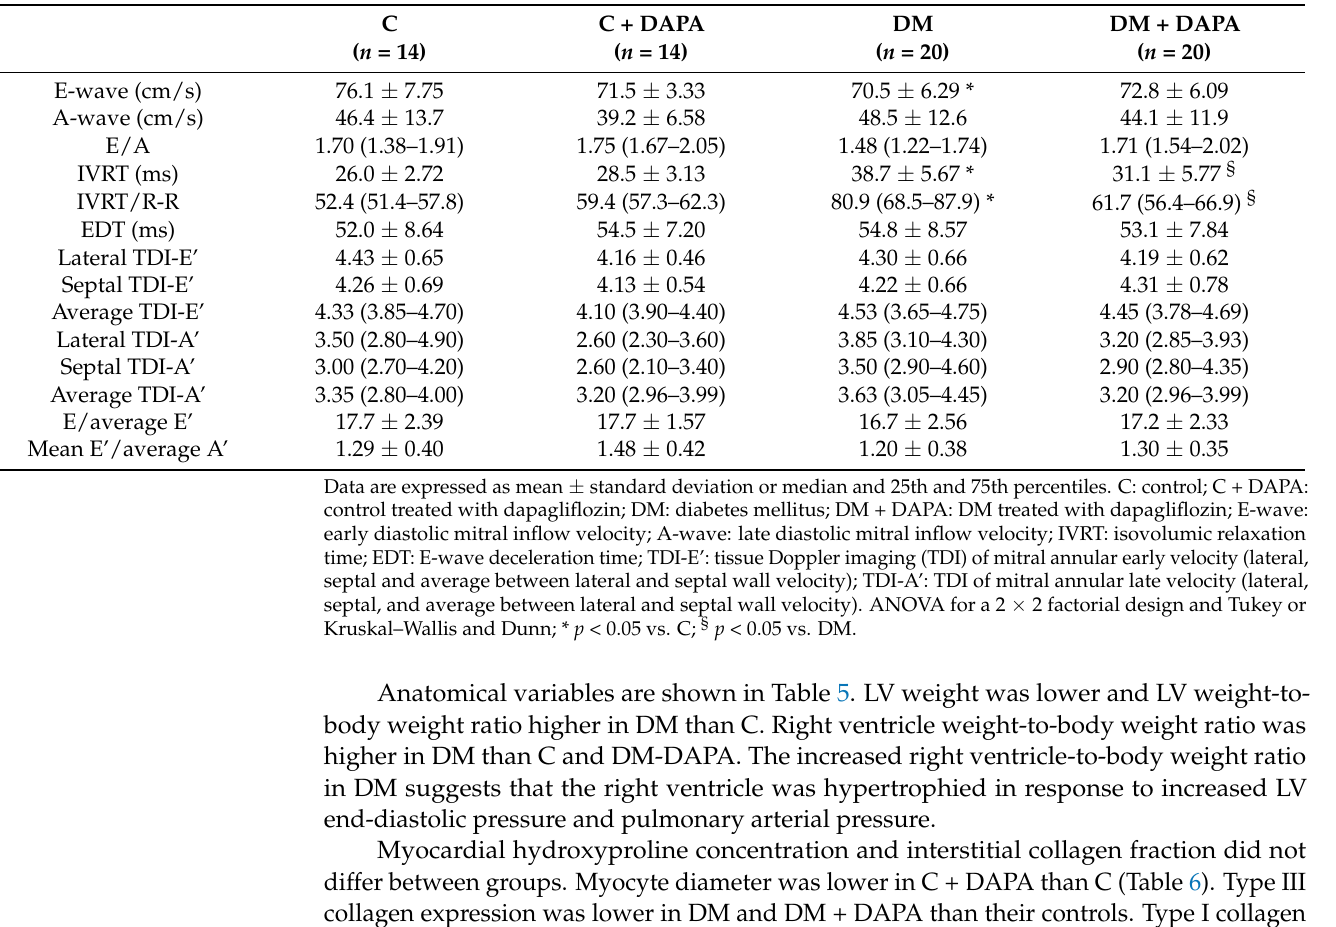
Table 4. Echocardiographic data for left ventricular diastolic